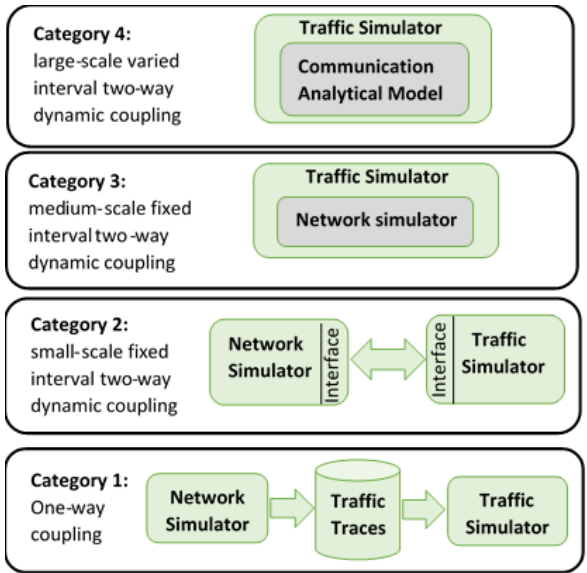
Figure 1. Integrated simulator